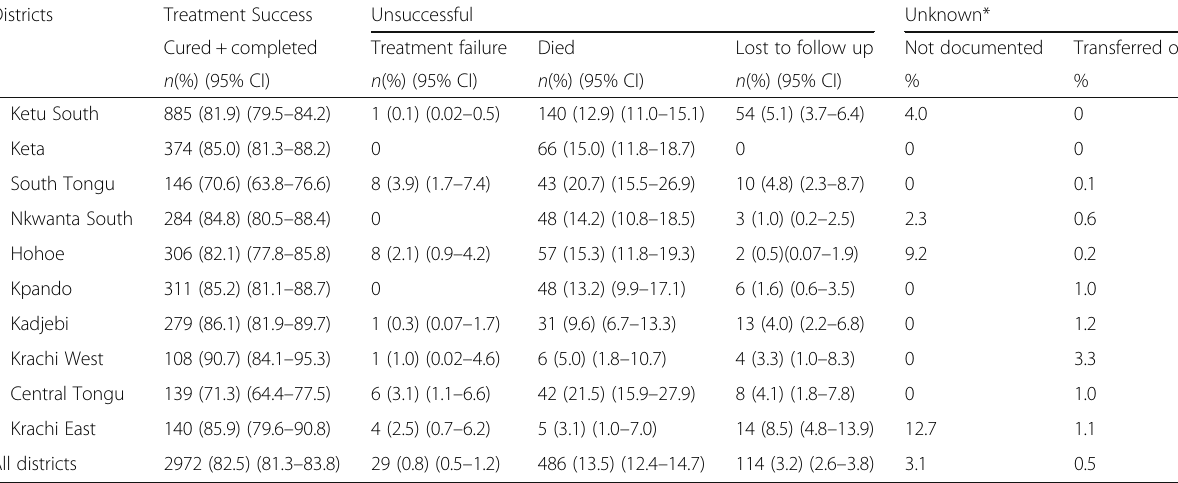
Table 2 Five-year treatment outcomes of Tuberculosis by district, 2012-2016